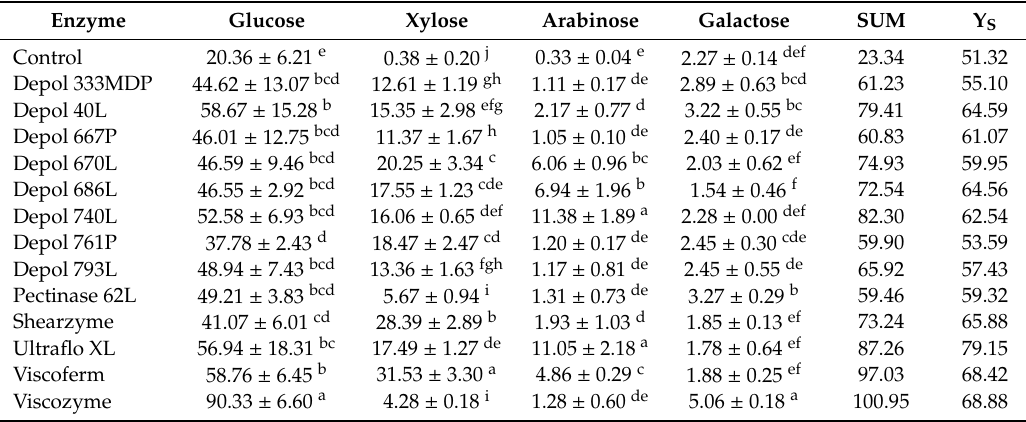
Table 1. Monosaccharide content (mg / g of bran) and solubilization yield (Ys, %) of wheat bran (WB) treated by 13 commercial food-grade